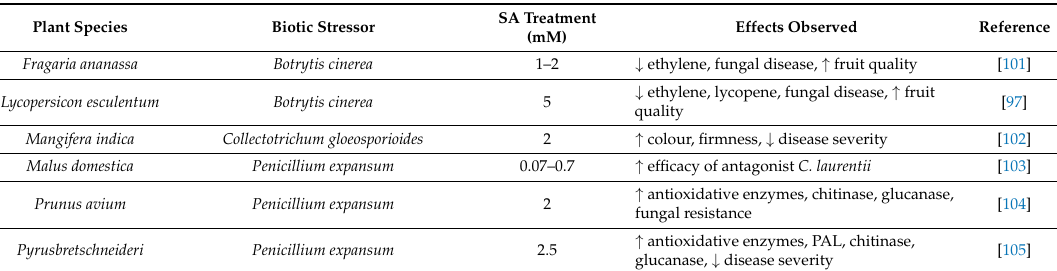
Table 5. Effects of SA in biotic stress